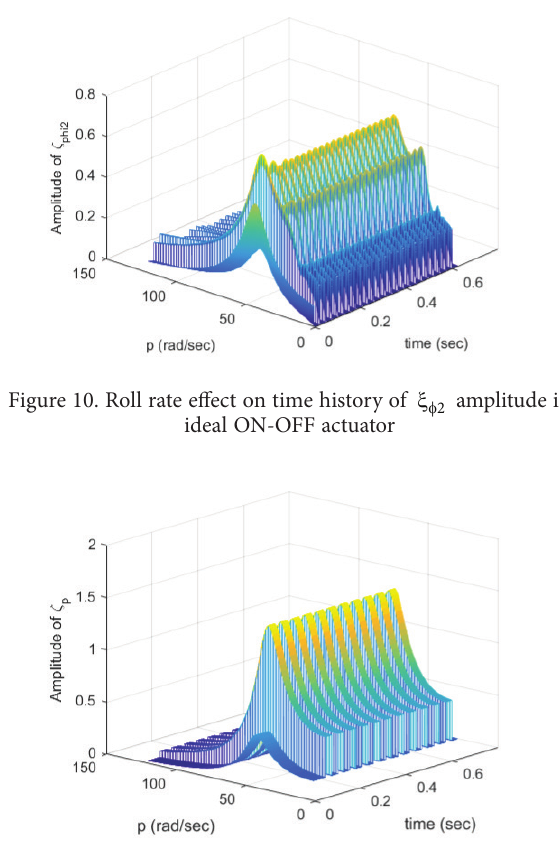
Figure 8. Ti me history of p ξ amplitude in ideal ON-OFF actuator for p = 15 Hz